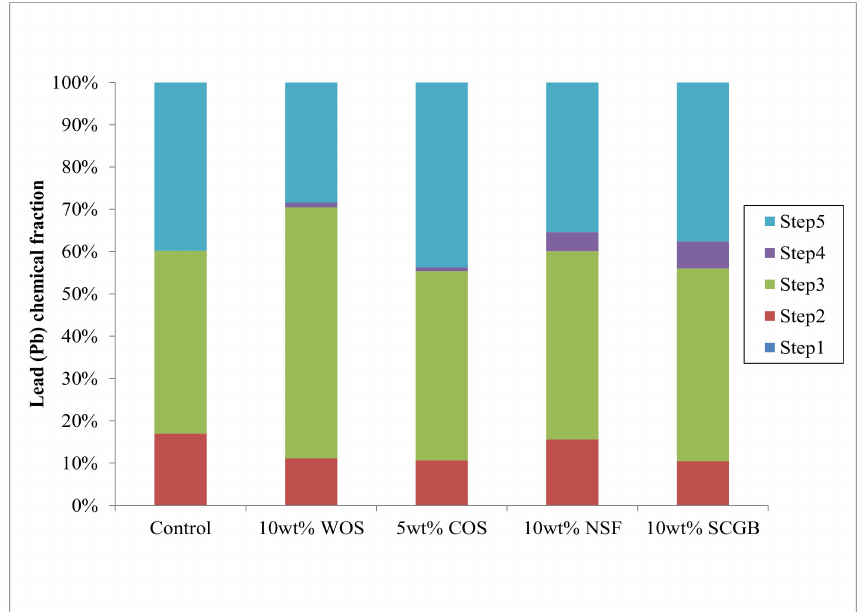
Figure 5. Lead (Pb) chemical fractions for the control sample, 10 wt% waste oyster shells (WOS), 5 wt% calcined oyster shells (COS), 10 wt% natural starfish (NSF), and 10 wt% spent coffee grounds derived biochar (SCGB) treated